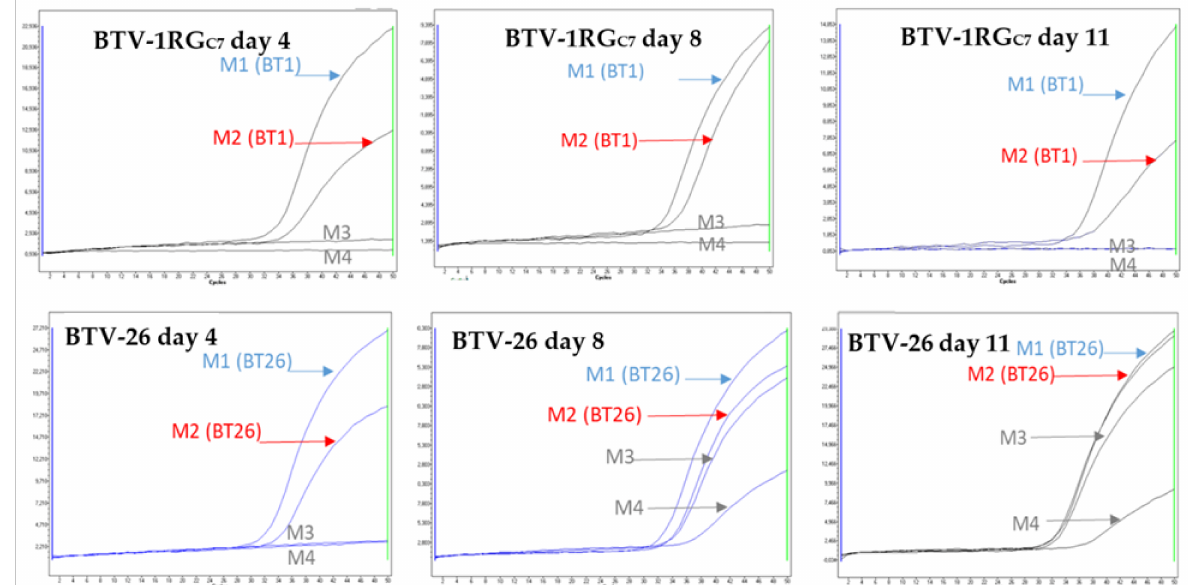
Figure 5. Real-time RT-PCR amplification curves of RNA extracts from blood samples of animals inoculated with BTV-1RG C7 or BTV-26 (M1 and M2 are the mice inoculated with the virus. M3 and M4 are the in-contact mice).